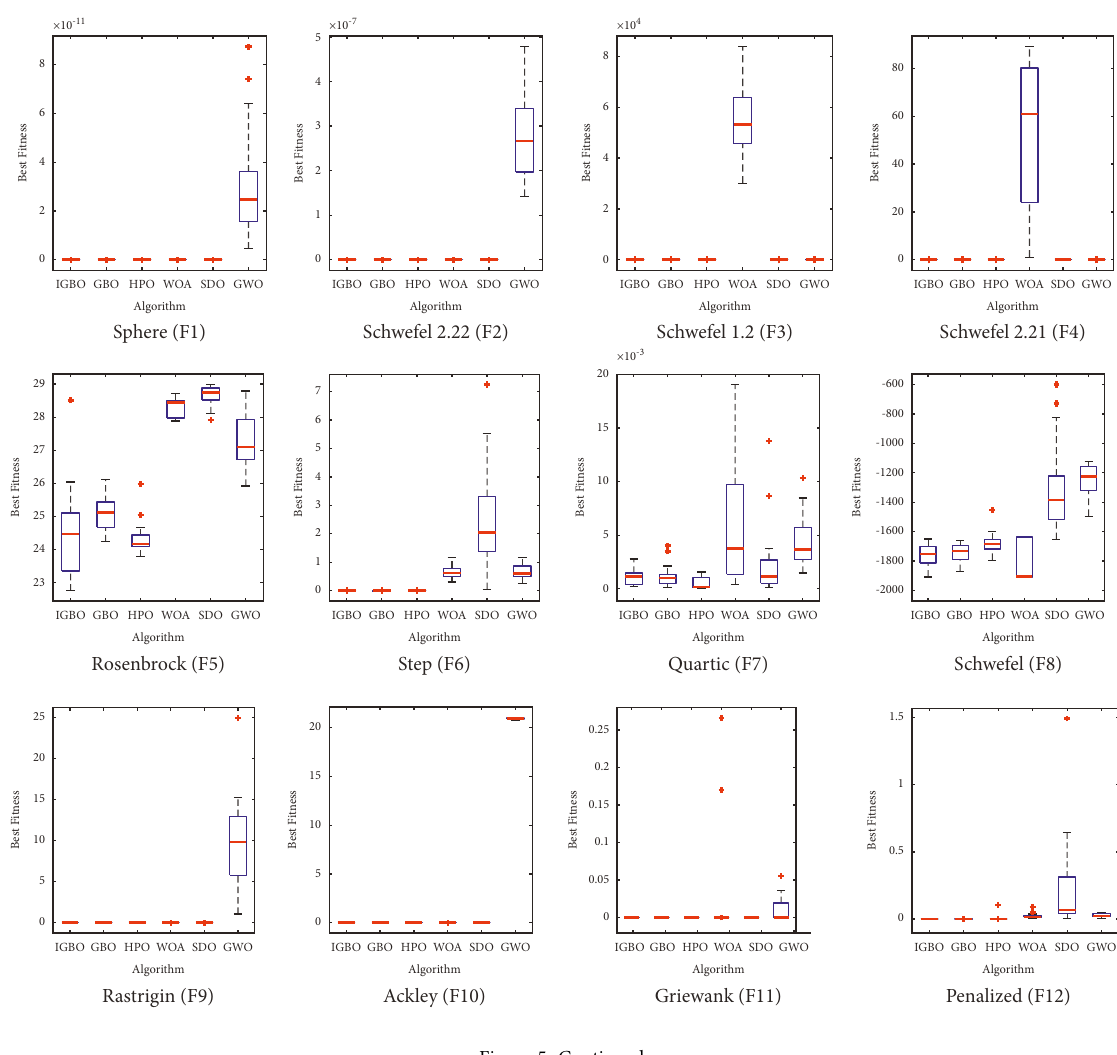
Algorithm02468 n F i t s t B e